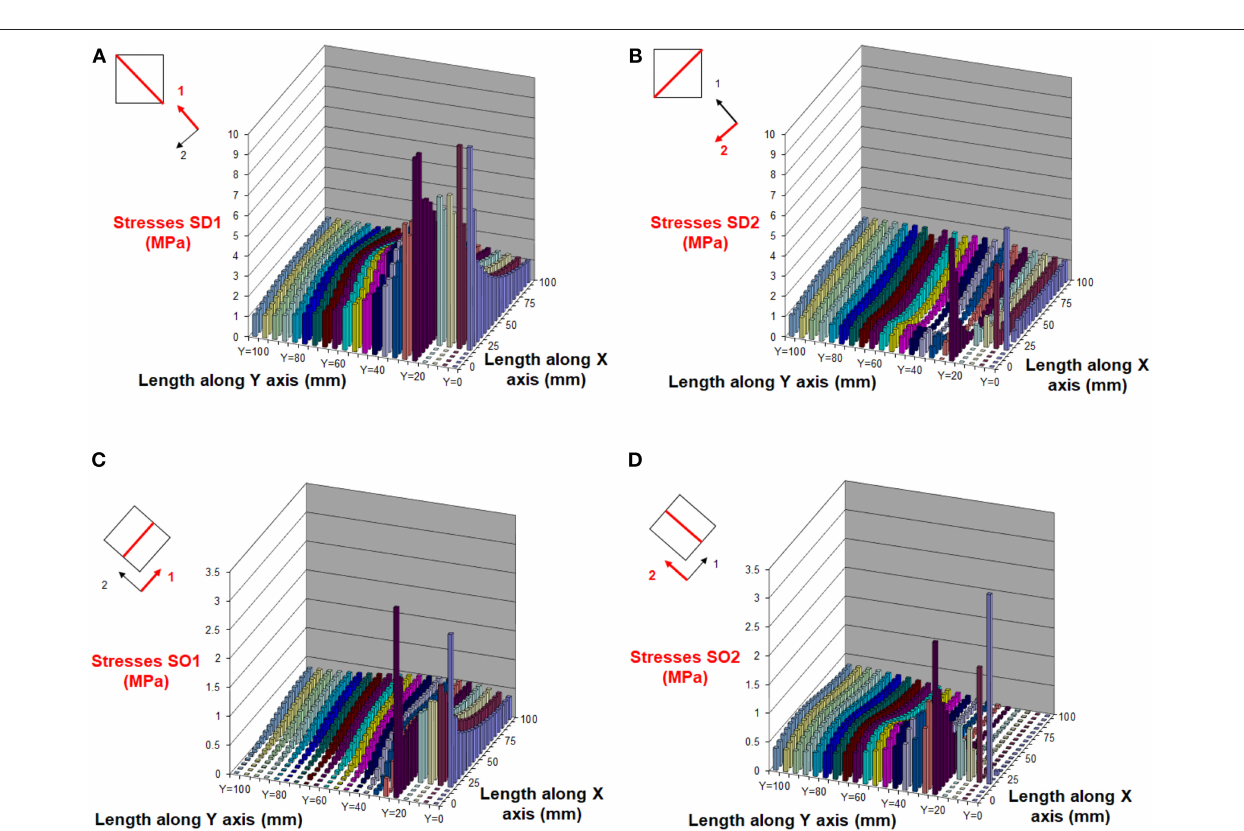
200 mm: along diagonal (A,B) and orthogonal (C,D) direction. The round corner stresses are ×